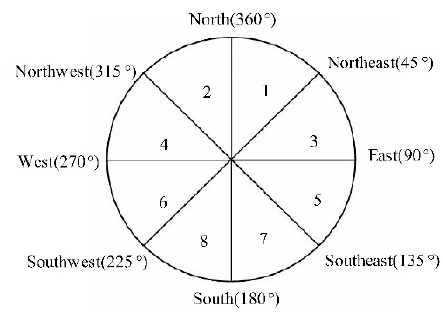
Figure 2. Number assigned to each sampling site according to its aspect.